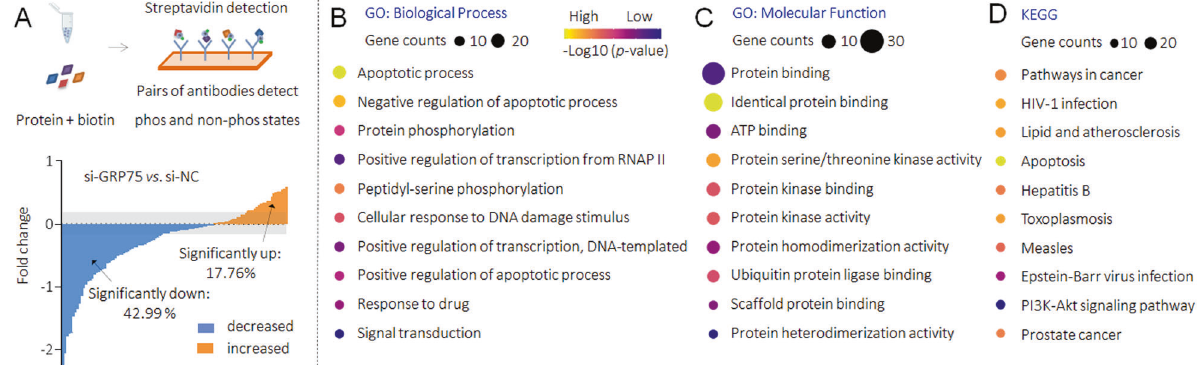
Fig. 4 GRP75-induced phosphorylation of apoptosis-related proteome modi fi cation in HCC cells. A The apoptosis phospho antibody array analysis of the changes of phospho-proteins following GRP75 knockdown in HepG2 B[a]P cells. Upregulation of phosphorylation by more than 1.2-fold is shown in orange, and downregulation of more than 1.2-fold is shown in blue. B – D GO and KEGG pathway enrichment analyses of the differential proteins. The size of the circle indicated the number of genes enriched, and different color shades indicated the size of p